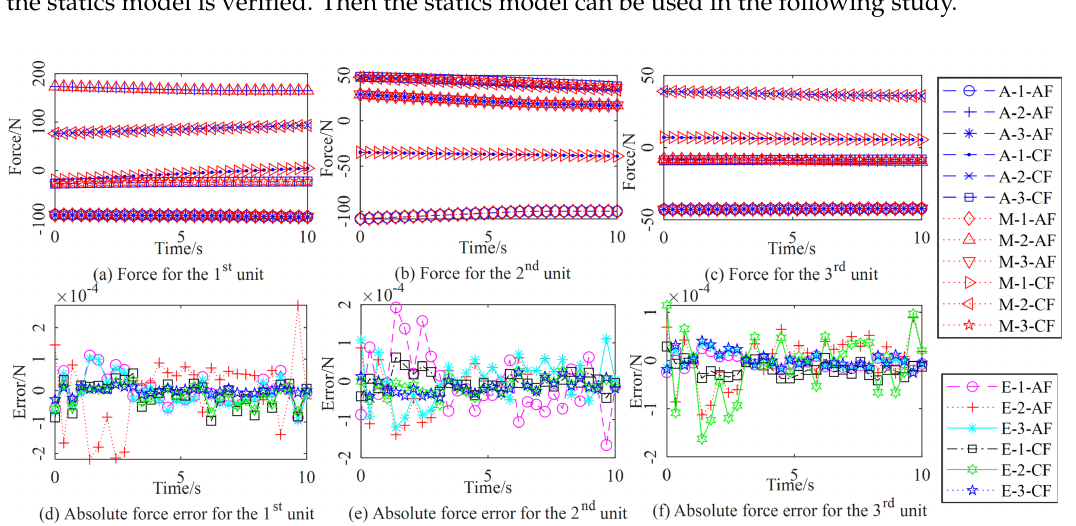
Figure 4. Comparisons between Adams measurement and Matlab calculation (‘A’ stands for ‘Adams measurement’, ‘M’ for ‘Matlab statics model’, ‘E’ for ‘absolute force error’ between results obtained from two ways for the same force, ‘AF’ for ‘active force’, ‘CF’ for ‘constrained force’, the number ‘1,2,3’ for the sequence number of the chain. For example, ‘A-1-AF’ stands for the active force of 1st chain obtained from Adams measurement, and ‘M-3-CF’ stands for the constrained force of 3rd chain obtained from Matlab